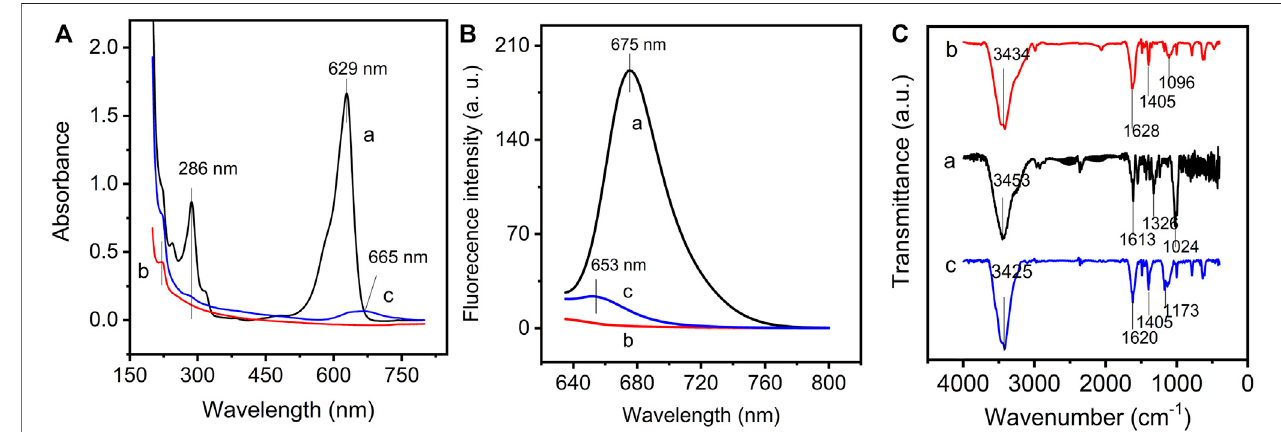
FIGURE 1 | (A) UV – vis spectra, (B) fl uorescence spectra, and (C) FTIR spectra of new methylene blue (NMB) (curve a), graphene oxide (GO) (curve b), and graphene oxide – new methylene blue (GO – NMB) (curve